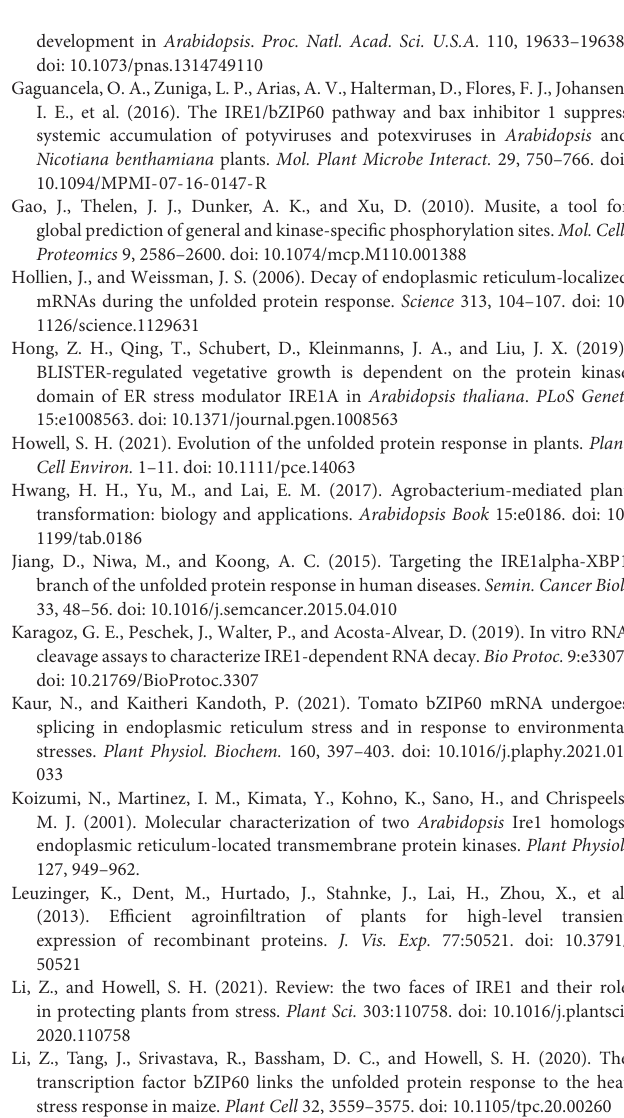
Supplementary Table 1 | Details on the manufacturers and catalog numbers of the chemicals, consumables, reagents, and oligonucleotides used in the study. Supplementary Text | Description of equipment used for the below-described